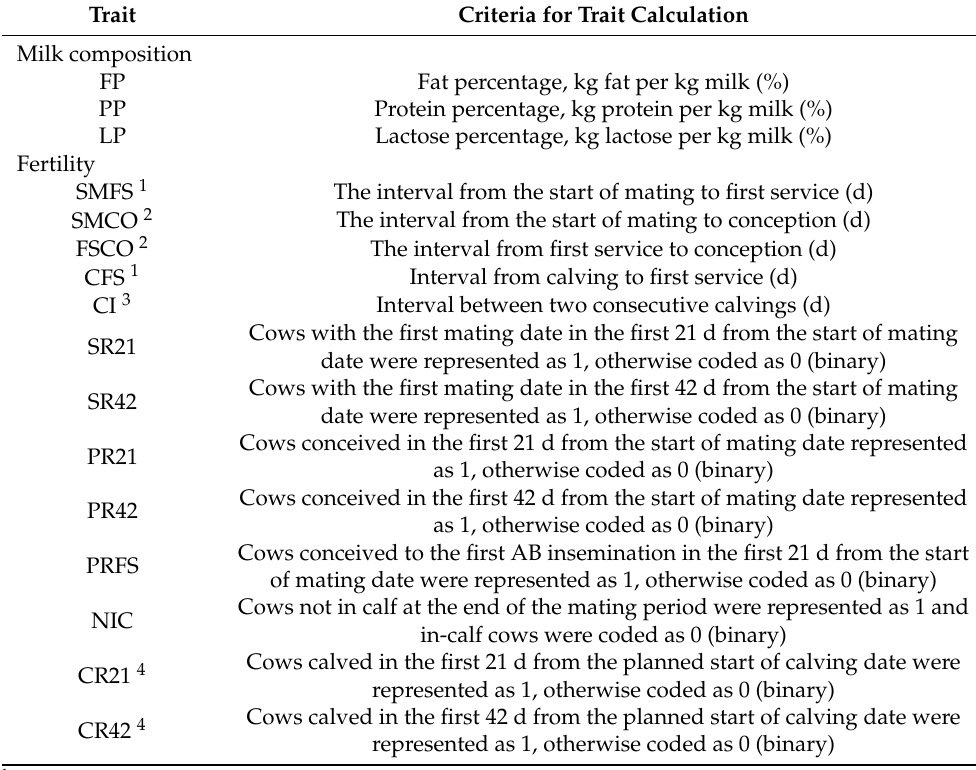
Table 1. Description of phenotypic (milk composition and fertility) traits used in this study. Trait Criteria for Trait